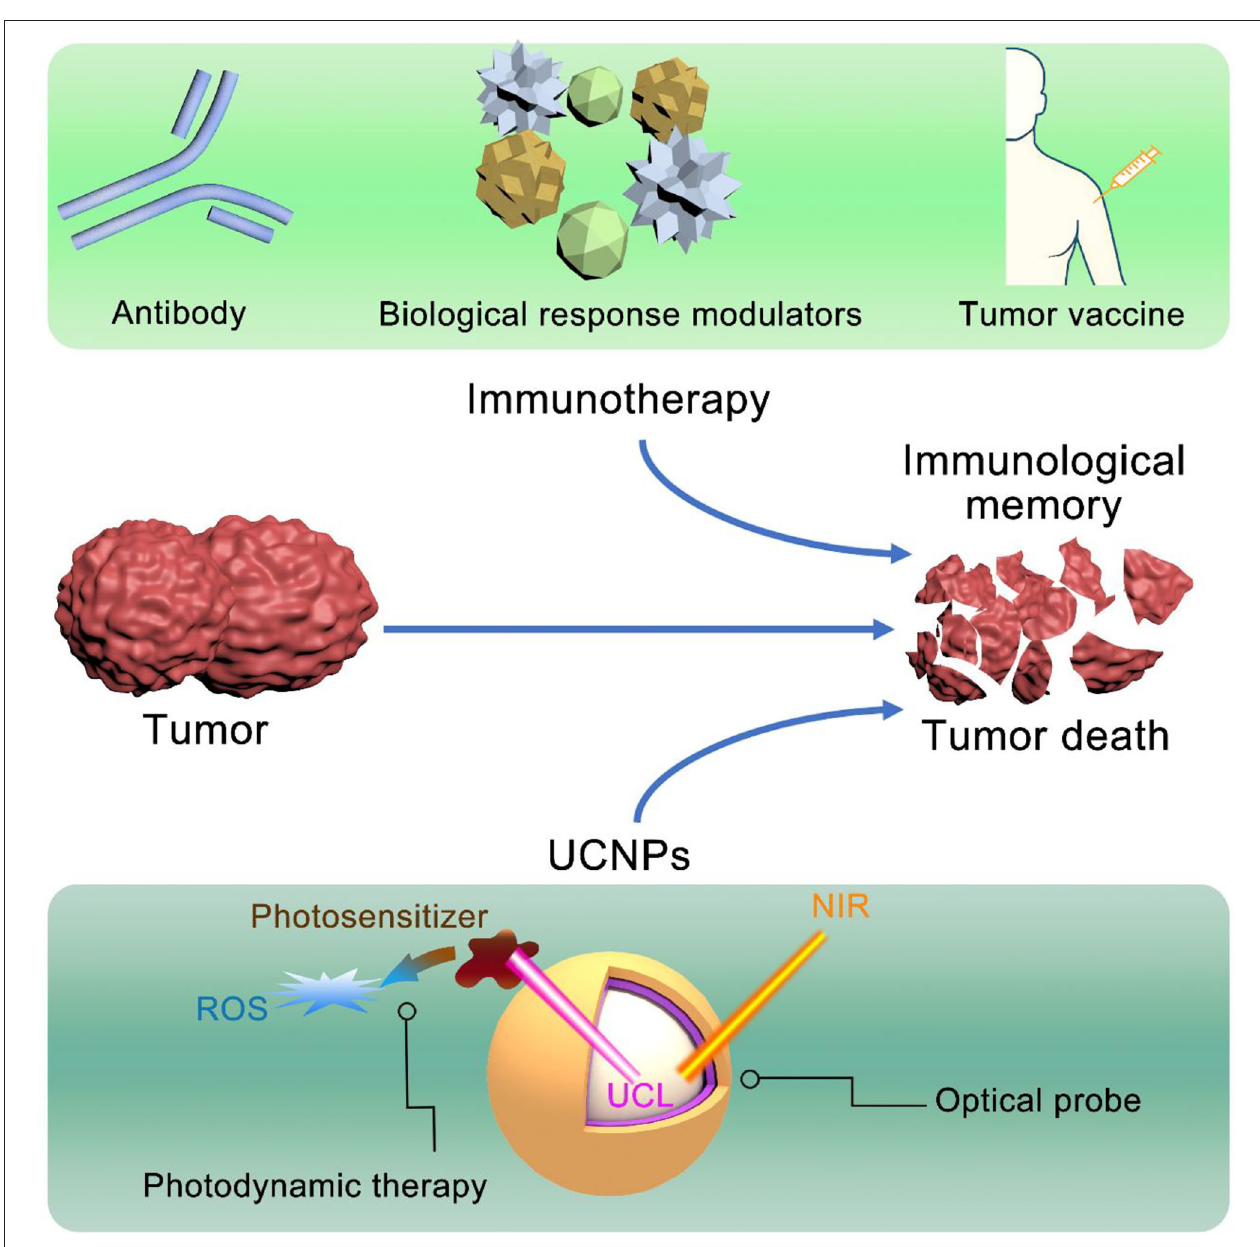
FIGURE 1 | The combination of UCNPs and